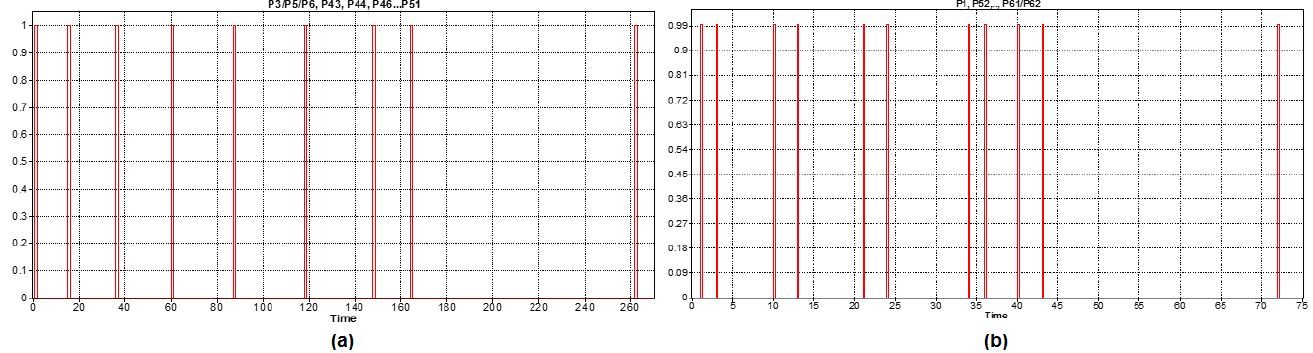
Figure 14. Monitoring signals for assembly operation steps from PN Sirphyco simulation: ( a ) WP 1, ( b ) WP 2.